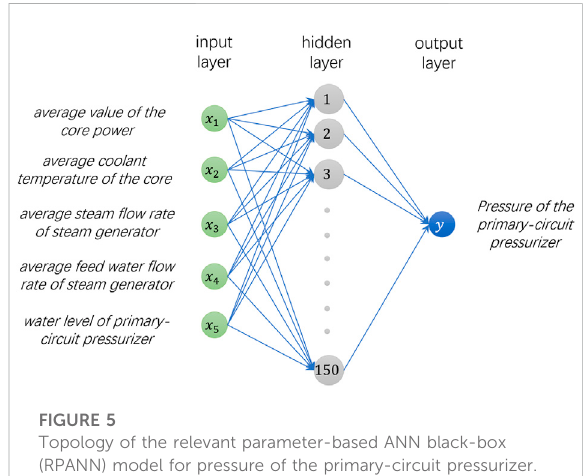
FIGURE 5 Topology of the relevant parameter-based ANN black-box (RPANN) model for pressure of the primary-circuit pressurizer.